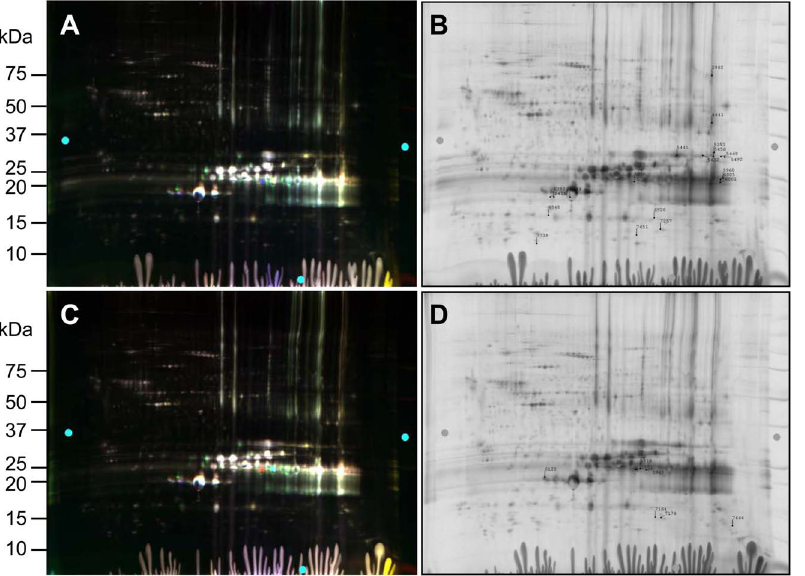
Figure 6. 2D-DIGE analysis of proteomic changes in whole lenses of 14-day-old mice induced by knock-in of the a B-R120G mutation. (A) 2D gel of lens proteins labeled with cyanine dyes derived from WT1 proteins labeled with Cy5, WT2 proteins labeled with Cy3, and a B- R120G heterozygous lens proteins labeled with Cy2. (B) 2D gel of lens proteins labeled with cyanine dyes derived from WT1 proteins labeled with Cy2, WT2 proteins labeled with Cy3, and a B-R120G homozygous proteins labeled with Cy5. (C, D) Protein spots that were selected for analysis from the gel shown in (A) and (B) are shown in (C) and (D), respectively. Proteins were identified by tandem mass spectrometry and Mascot searches of spots that were selected from analysis of the gels. Quantitative image analysis and mass spectrometry data for the identified proteins from these gels are listed in Table 4.